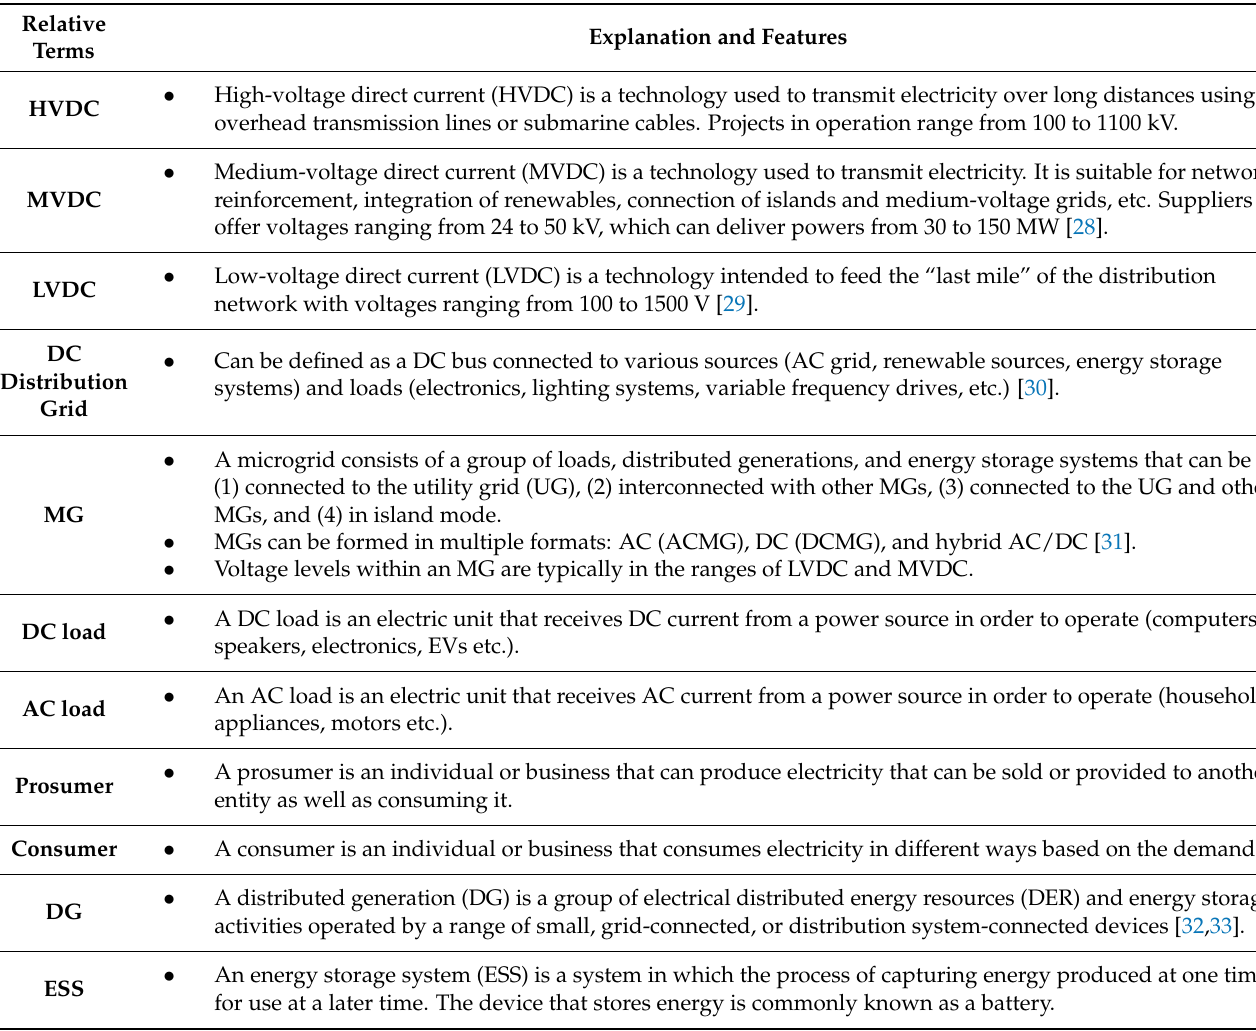
Table 1. Relevant terms of DC power